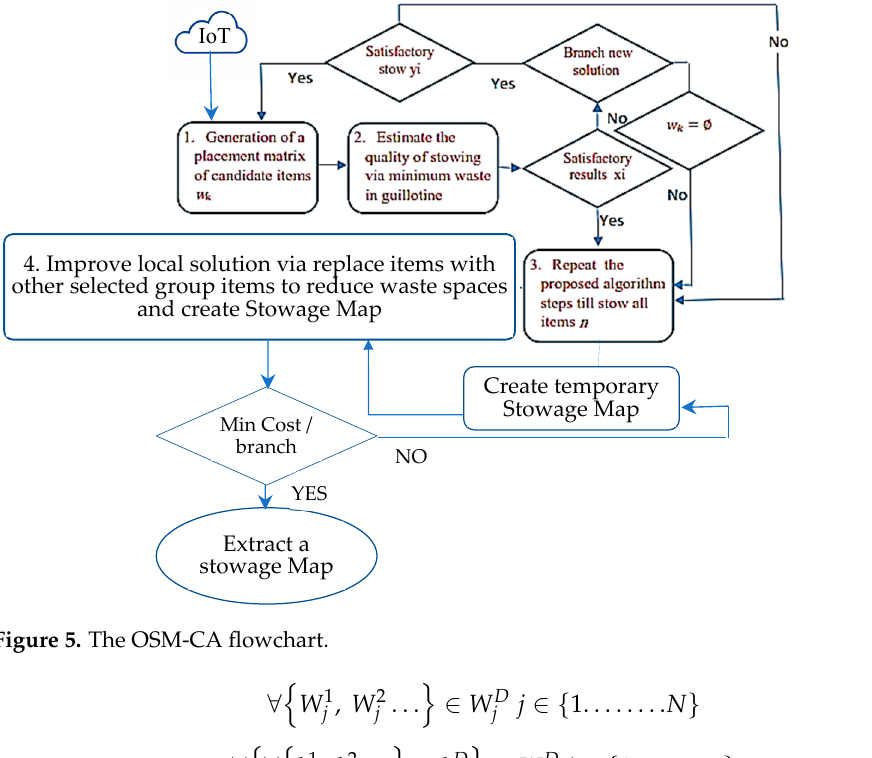
Figure 5. The OSM-CA flowchart.